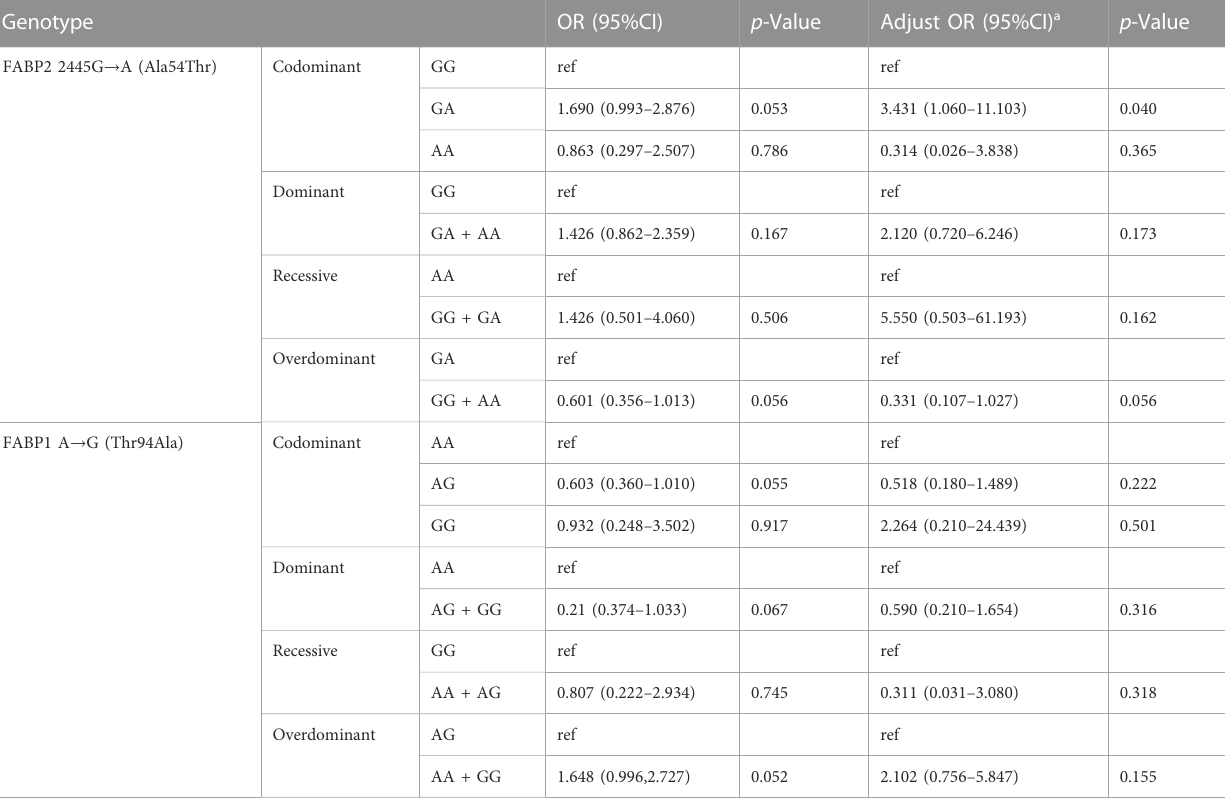
TABLE 3 Association analysis between SNPs and risk of ischemic stroke.